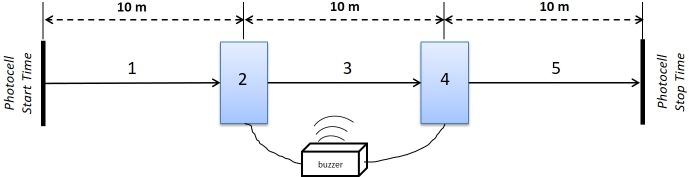
Schematic representation of Stop and Go test.